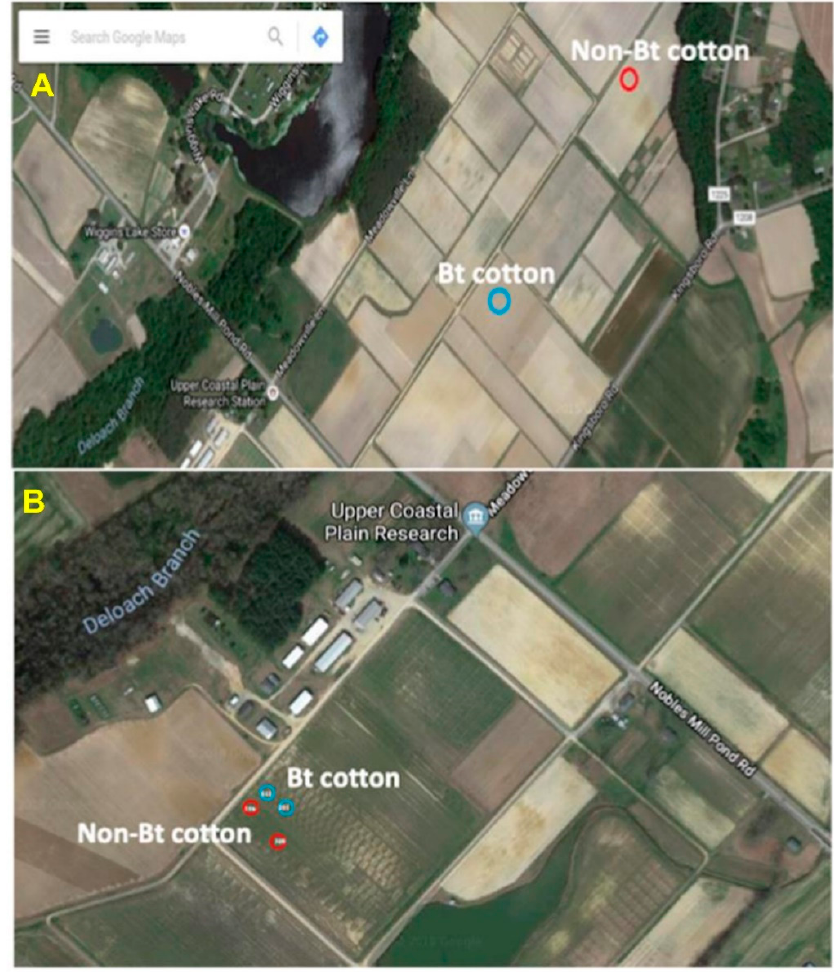
Figure 1. Helicoverpa zea collection sites at the Upper Coastal Plain Research Station, Rocky Mount, NC (USA). ( A ) Larvae were collected from two adjacent fields in the fall of 2016 from non-Bt and Bt (WideStrike, Cry1Ac + Cry1F) cotton; ( B ) larvae were collected from adjacent plots in the same field as indicated in the figure in the fall of 2018.